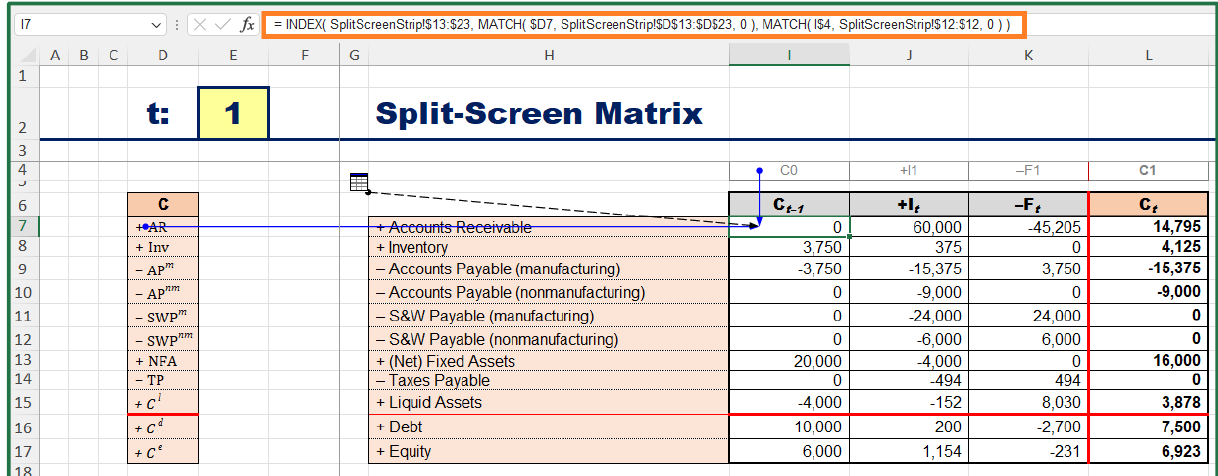
Figure 38. Cell J13 contains the value that has the same row-label as SiglePeriod!D7 ( +AR ) and the same column-label as SiglePeriod!I4 ( 𝐶 (cid:2868) ) (“SplitScreenStrip” sheet). The formula written for cell I7 can then be used for cells J7 and K7 as well: J7 = INDEX( SplitScreenStrip! $13: $23, MATCH( $D7, SplitScreenStrip! $D$13: $D$23, 0 ), MATCH( J$4, SplitScreenStrip! $12: $12, 0 ) ) The analyst can then copy cell I7 and paste it in cells J7 and K7. Cell L7 contains the for- mula that applies the law of motion: 𝐶 (cid:3047) = 𝐶 (cid:3047)(cid:2879)(cid:2869) + 𝐼 (cid:3047) − 𝐹 (cid:3047) L7 (cid:3605) (cid:2885)(cid:2902) (cid:3295) =